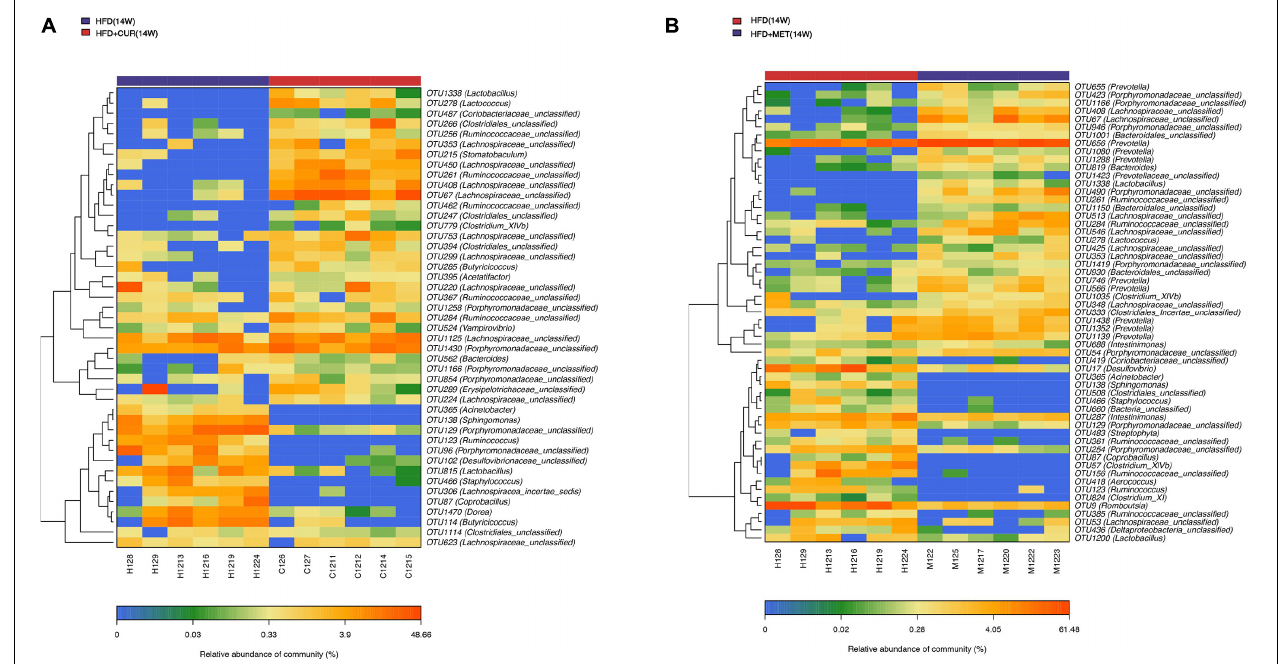
FIGURE 10 | Responses of the structure of the gut microbiota to CUR and MET treatment. (A) The changing direction of the OTUs by CUR. (B) The changing direction of the OTUs by MET. Red and blue colors indicate the abundance of OTUs that were more and less abundant, respectively, in HFD + CUR (14W) group and HFD + MET (14W) group relative to HFD (14W) group.